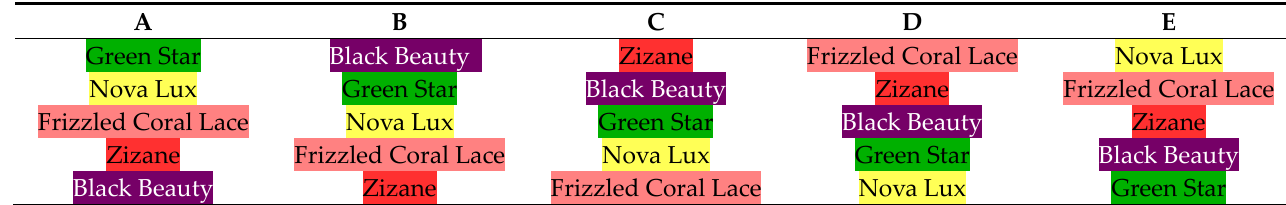
Table 2. Planting design: A: Control; B: Fitofolis; C: Bionat Plus; D: Cropmax; E: The mixture of Fitofolis, Bionat Plus and Cropmax (F + B + C).